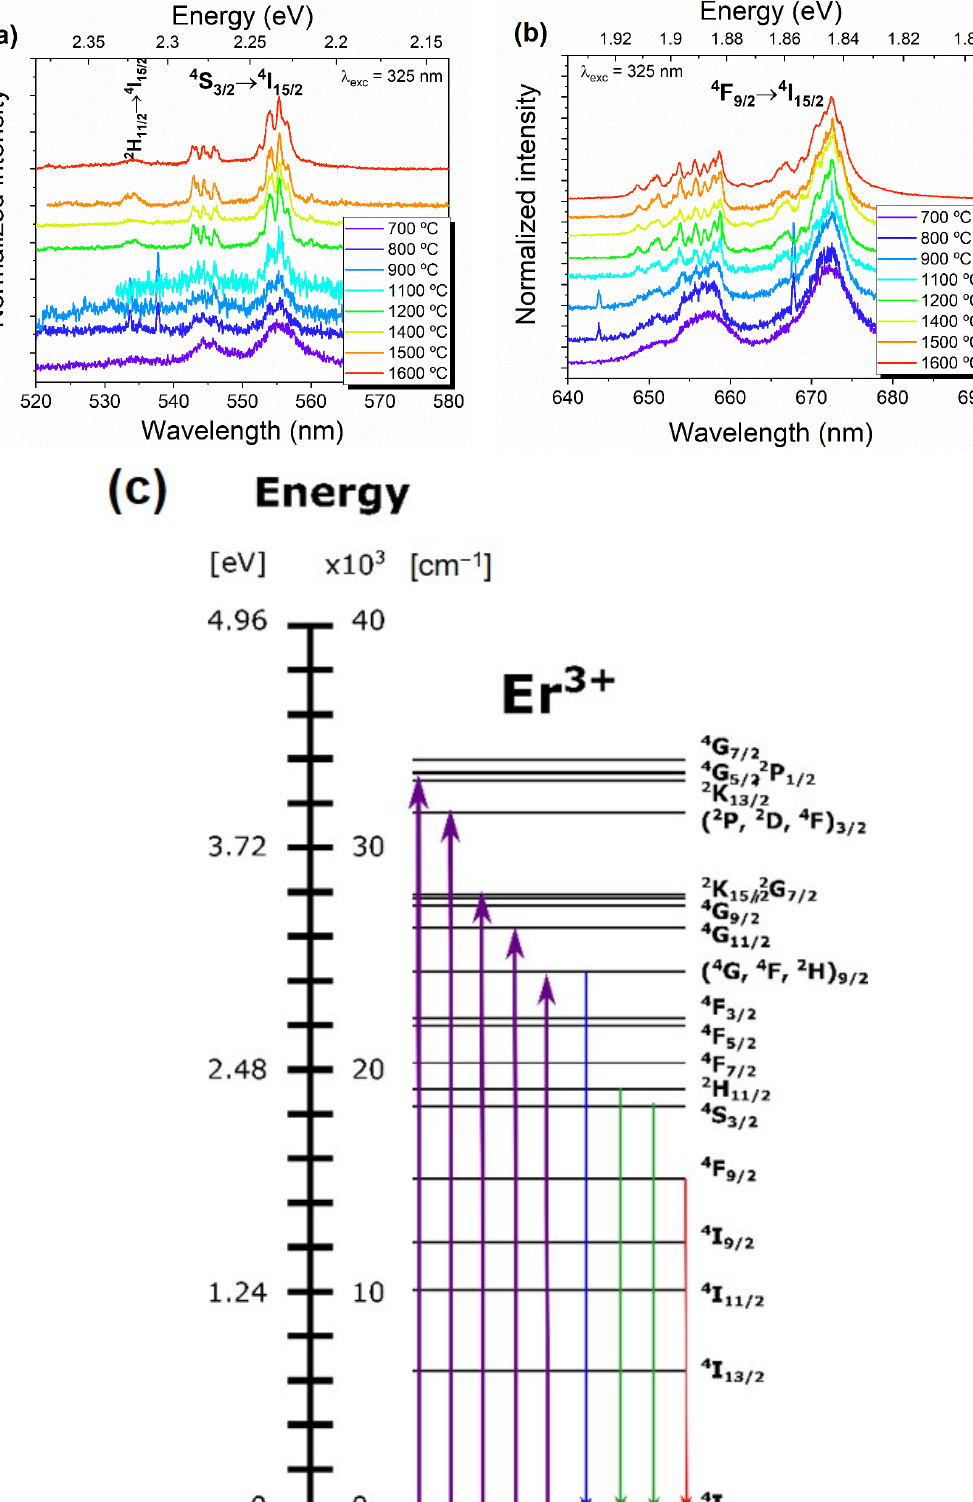
Figure 9. ( a ) High-resolution RT normalized; ( b ) PL spectra of HT erbium niobate samples assessed with the 325 nm line of a cw He-Cd laser; ( c ) schematic free ion energy levels of Er 3+ and observed transitions in erbium niobate (energy level constructed based on [13]).